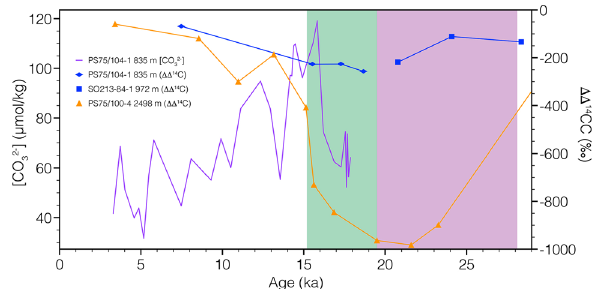
Figure 4. PS75/104-1 [CO3 2− ] (purple line) vs. intermediate and deep-water ΔΔ 14 C 15 . Blue diamonds— PS75/104-1; blue squares—SO213-84-1; orange triangles—PS75/104-1. Purple and green shading—glacial and early deglacial interval of potential CO 2 -release from pockmarks 26